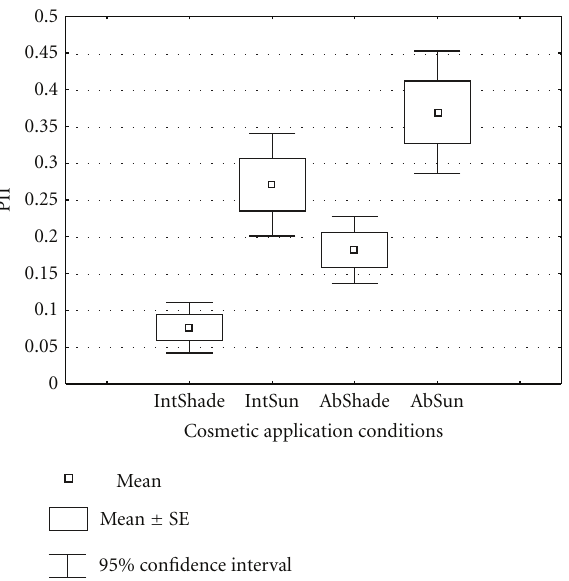
Figure 2: Box plot of primary irritation index (PII) of cosmetics applied under di ff erent environmental conditions on a rabbit skin. IntShad: intact skin under shade, IntSun: intact skin under sun, AbShade: abraded skin under shade, and AbSun: abraded skin under